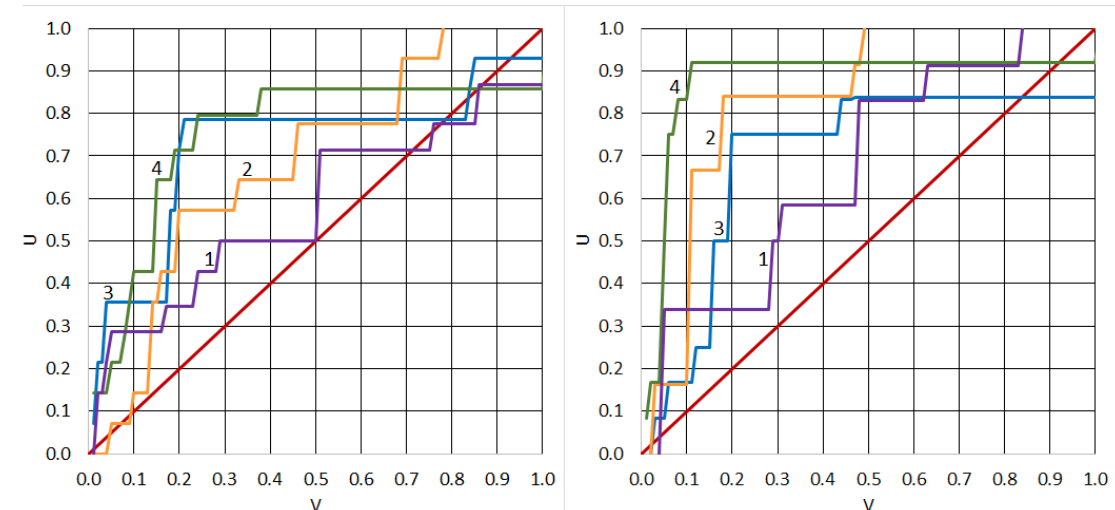
Figure 16. Dependences U ( V ) of the probability of a successful earthquake prediction U on the alarm volume V ob- tained with the different fields. ( Left ) Japan: (1) field S 7 ; (2) field F 10 ; (3) fields S 9 and S 10 ; (4) fields S 9 , S 10 , and F 10 . ( Right ) California: (1) field S 7 ; (2) fields F 4 and F 6 ; (3) fields S 9 and S 11 ; (4) fields S 9 , S 11 , F 4 , and F 6